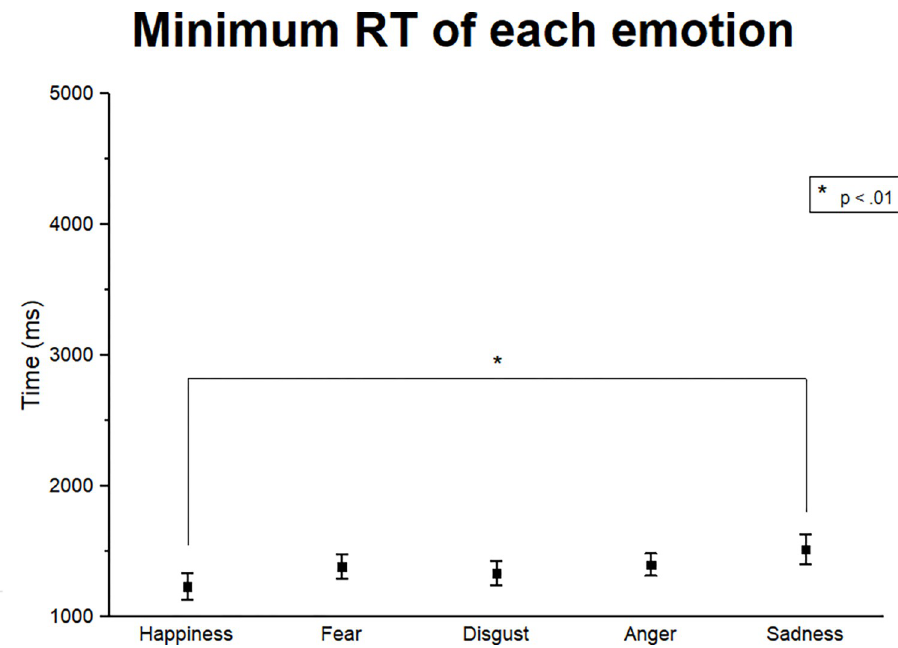
Fig 6. Minimum RT of each emotion for high-intensity facial expressions (80, 90 and 100). Means and standard errors of the minimum RT of each emotion for all odor conditions grouped. Happiness was recognized faster than sadness expressions (p < .005), but no other differences between emotions were observed. Significant differences are illustrated by asterisk